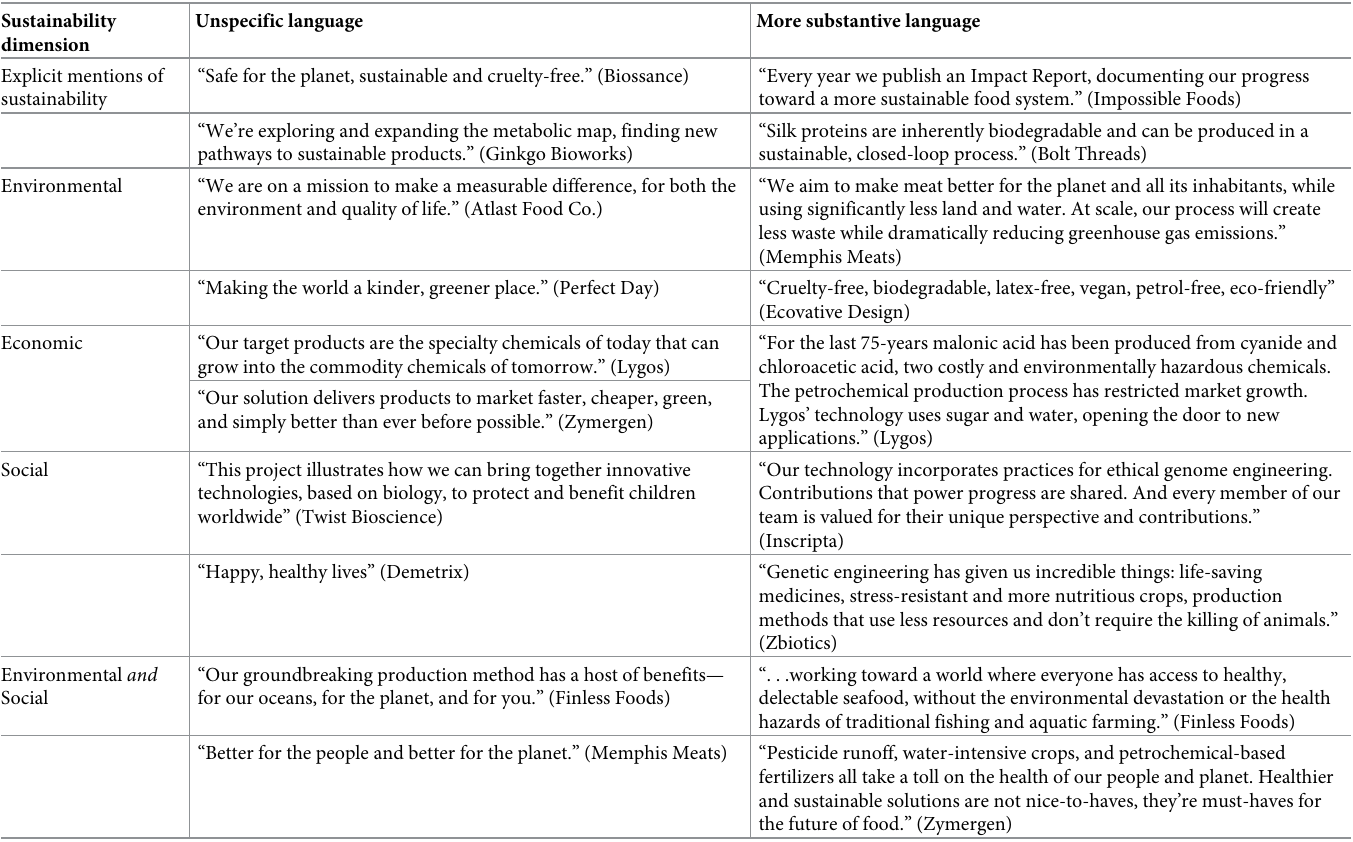
Table 1. Representative examples of unspecific and more substantive sustainability-related language on company